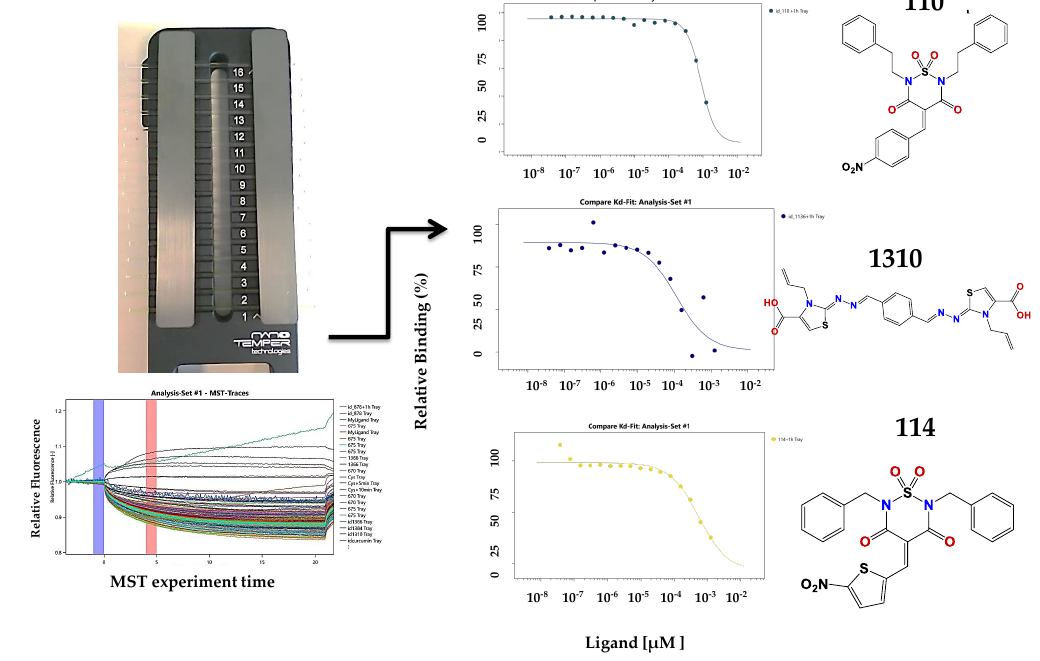
Figure 4. Left panel: schematic representation of the MST assay. It is the cassette with 16 capillary spaces to get 16 points in the doses response assay. On the right are some of the results